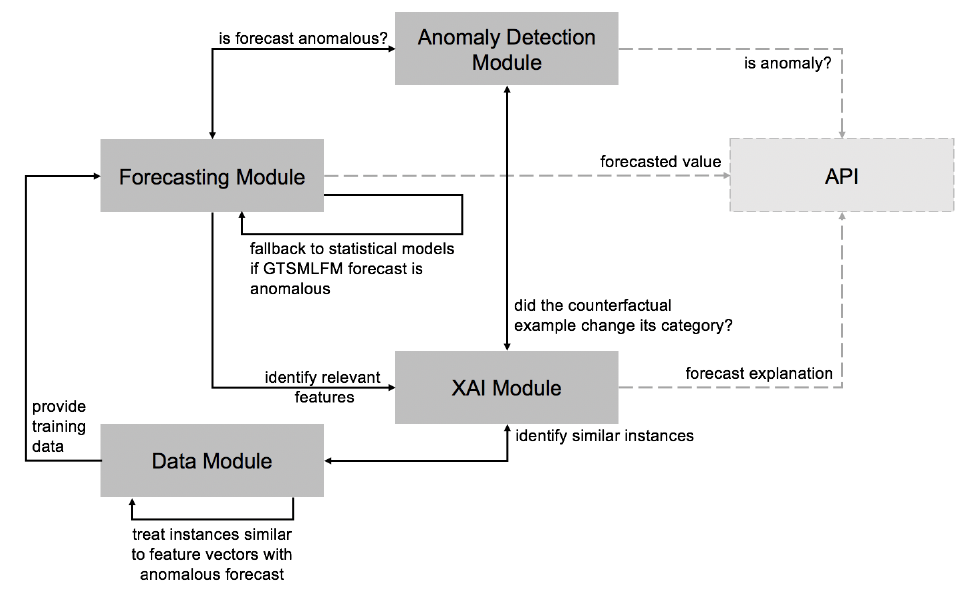
Figure 1. Architecture